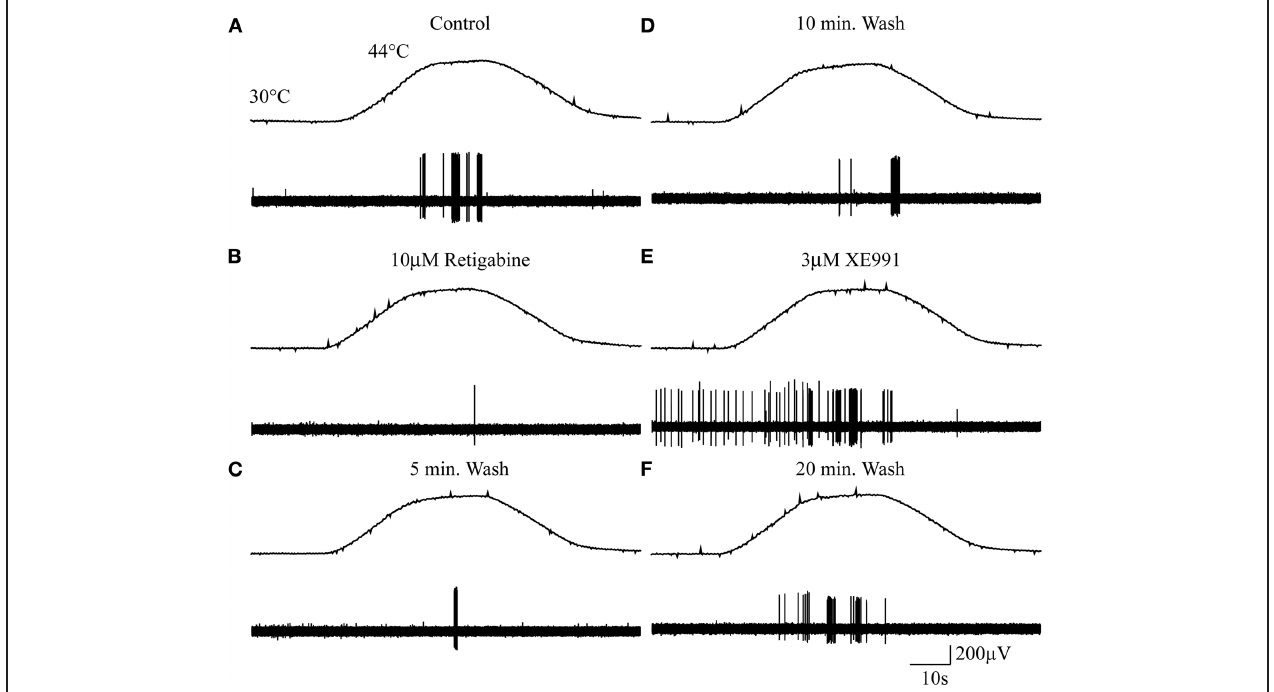
FIGURE 2 | Cutaneous sensory endings express functional M-channels. (A–F) Example of a mechano-heat (AMH) A δ -fiber response to noxious heat stimulation pre- and post-exposure to the M-channel modulators retigabine and XE991. Top panels in A–F show the noxious heat ramps that ramp from